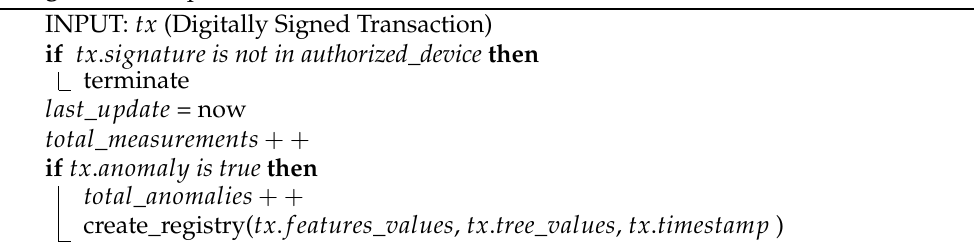
Algorithm 1: Update function used in the Smart